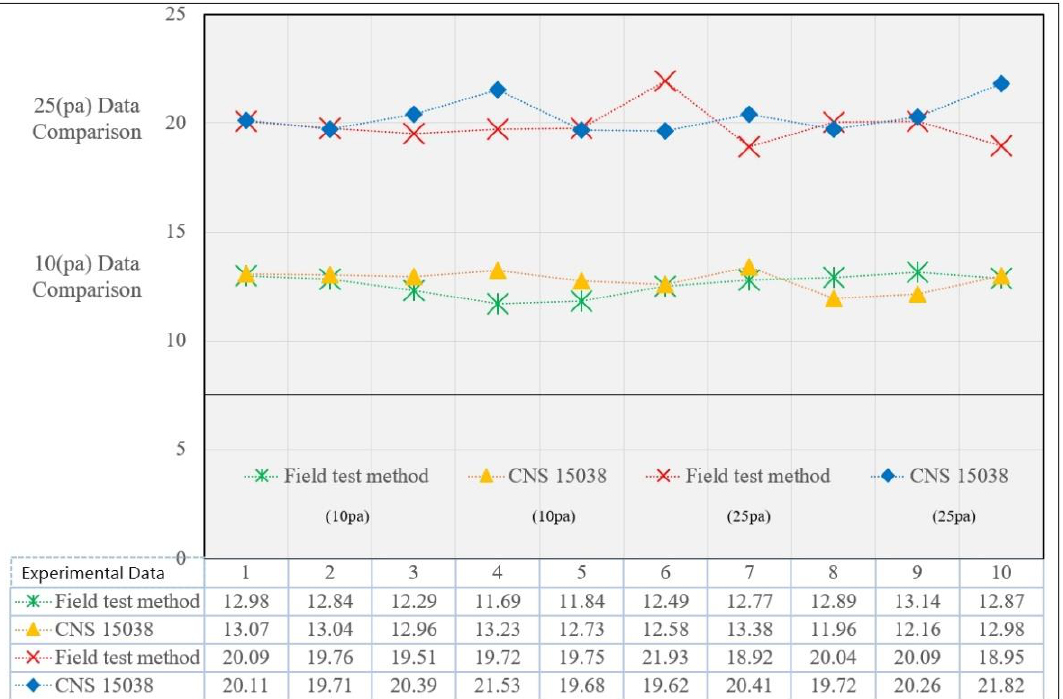
Figure 5. Smoke control field test method and CNS 15038 test results.